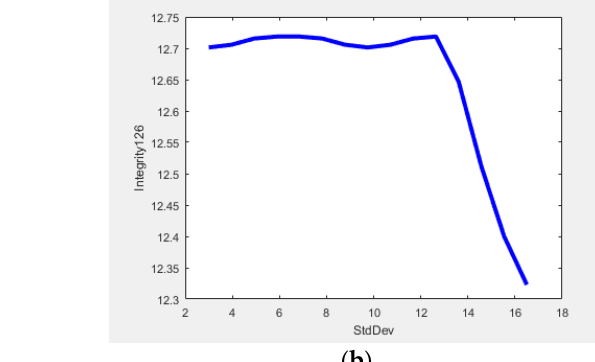
Figure 6. The SSN standard deviation ( x 2 ) and the integrity of PRN120 ( a ) and PRN126 ( b ) (Own study in MATLAB Fuzzy Logic Toolbox).